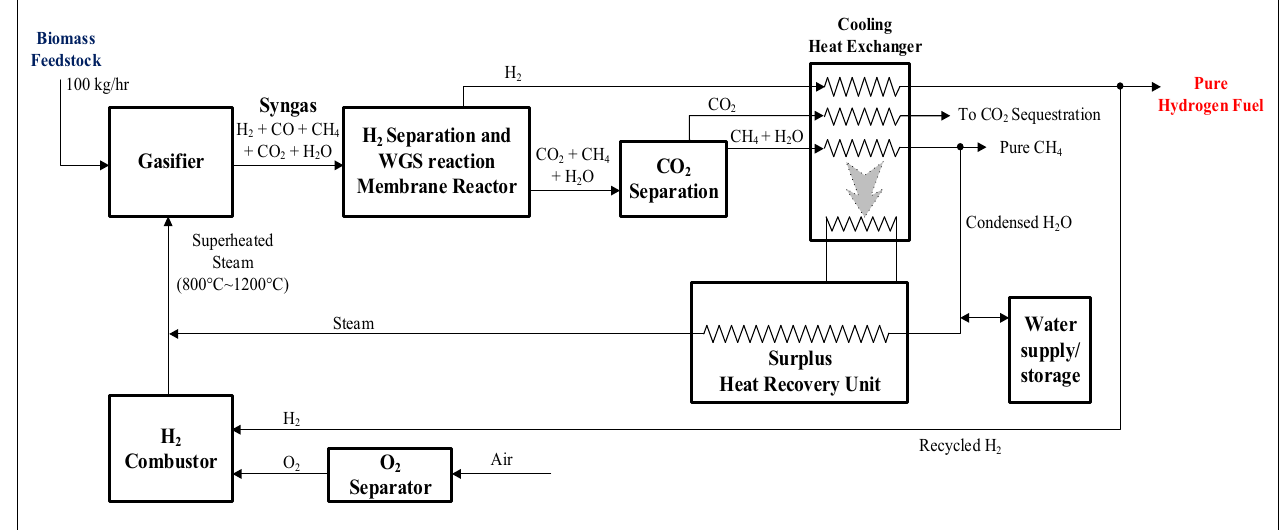
FIGURE 3 | Schematic of the integrated biomass to energy concept system I .